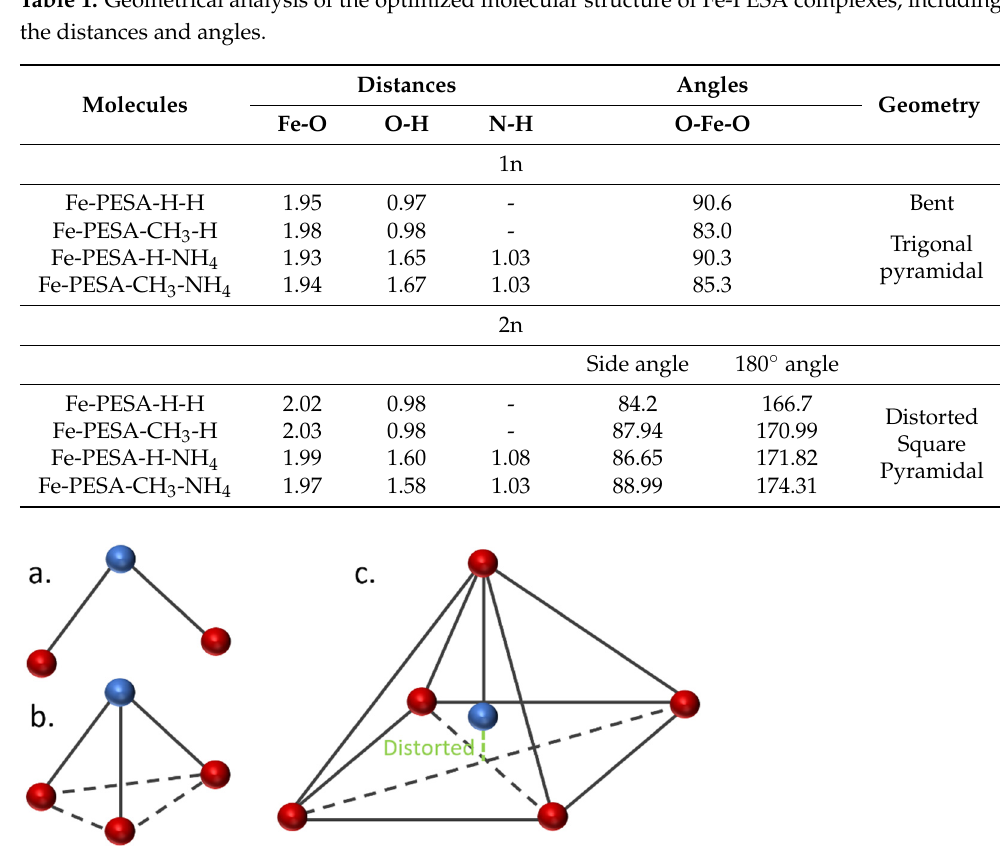
Figure 3. The optimized structure of Fe complex with 2-monomers of PESA molecule.